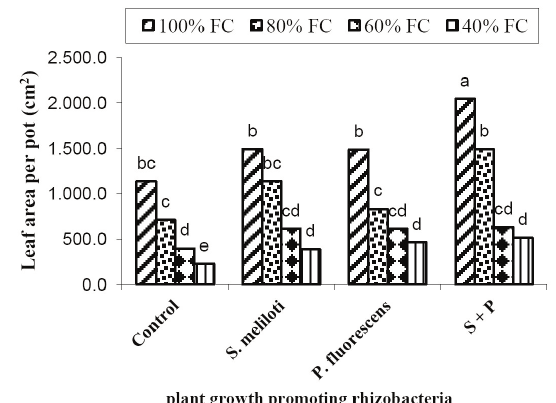
fig. 3 - Interaction of PGPR and soil water content on the shoot dry weight of